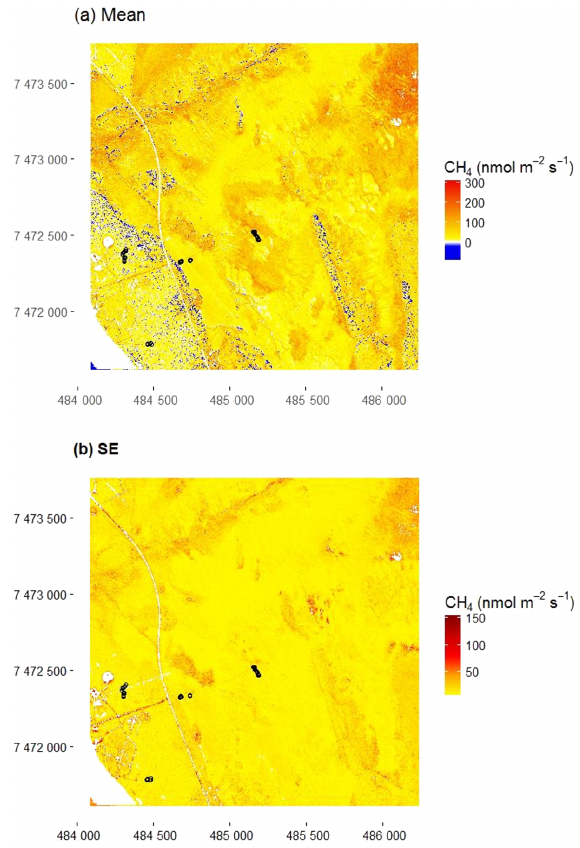
Figure 10. Mean (a) and SE (b) of CH 4 fluxes extrapolated over a 2km × 2km area predicted from chamber flux measure- ments (black circles), and satellite spectral data. Coordinates are in